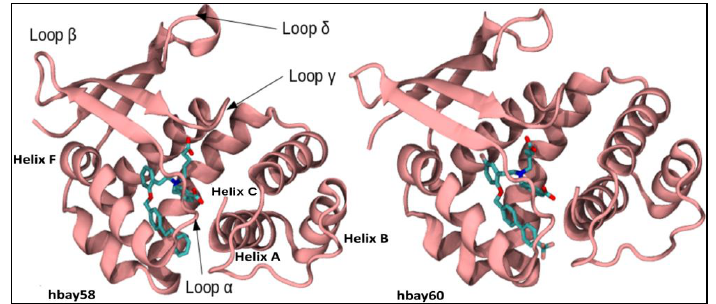
Figure 2. Models of h H-NOX bound with BAY58-2667 (hbay58) and BAY60-2770 (hbay60). h H-NOX domain consists of seven α helices and four β strands. Important secondary structure elements have been shown.